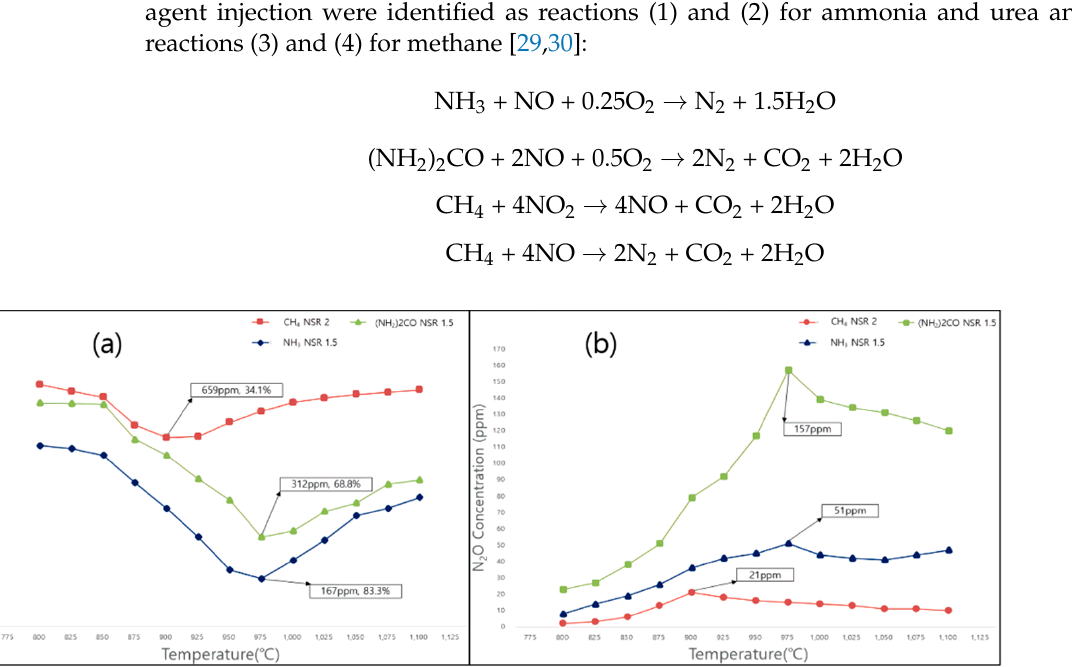
Figure 3. Effects of temperature on the levels of ( a ) NO x and ( b ) N 2 O obtained under optimal conditions (NO = 900 ppm, NO 2 = 100 ppm, O 2 = 7%, NH 3 and (NH 2 ) 2 CO NSR = 1.5, CH 4 NSR = 2) for (NH 2 ) 2 CO, NH 3 , and CH 4 as reducing agents.